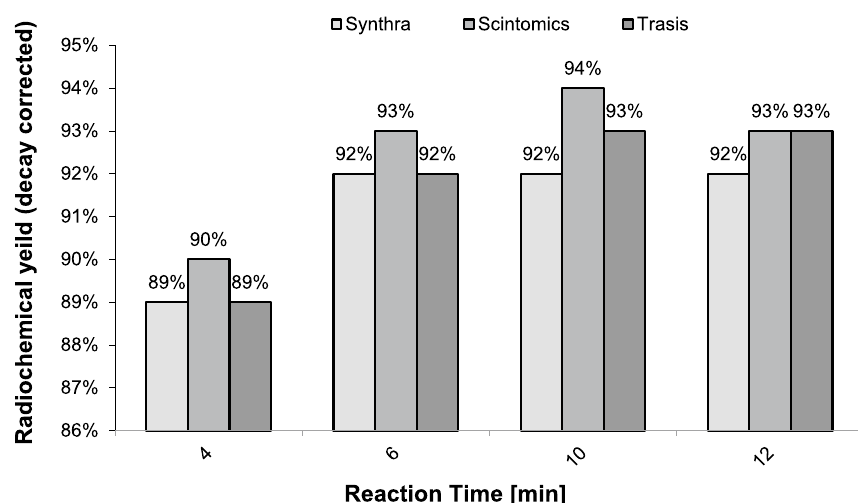
Fig. 7 Radiochemical yield of [ 68 Ga]Ga-FAPI-46 (n 95 °C and 50 µg of FAPI-46 in a buffered medium containing 300 µg ascorbic